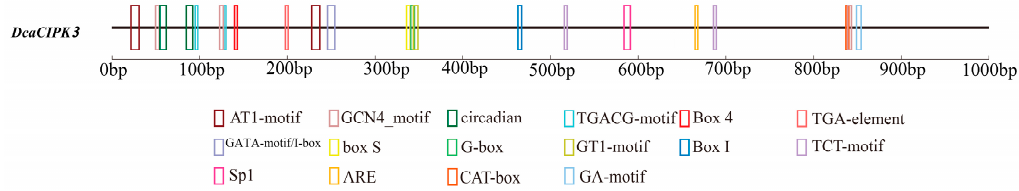
Figure 7. Analysis of the protein domains in main expressed transcripts of DcaCIPK 1/3. Green boxes represent pkinase domain. Red boxes represent NAF domain. Blue boxes represent KA1 domain. Grey lines represent amino acid sequences.